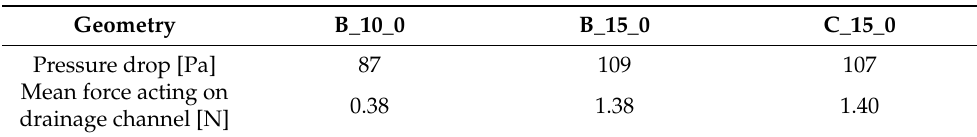
Table 15. Pressure drops on mist eliminators and the mean force acting on the drainage channel; inlet velocity 2 m s − 1 .